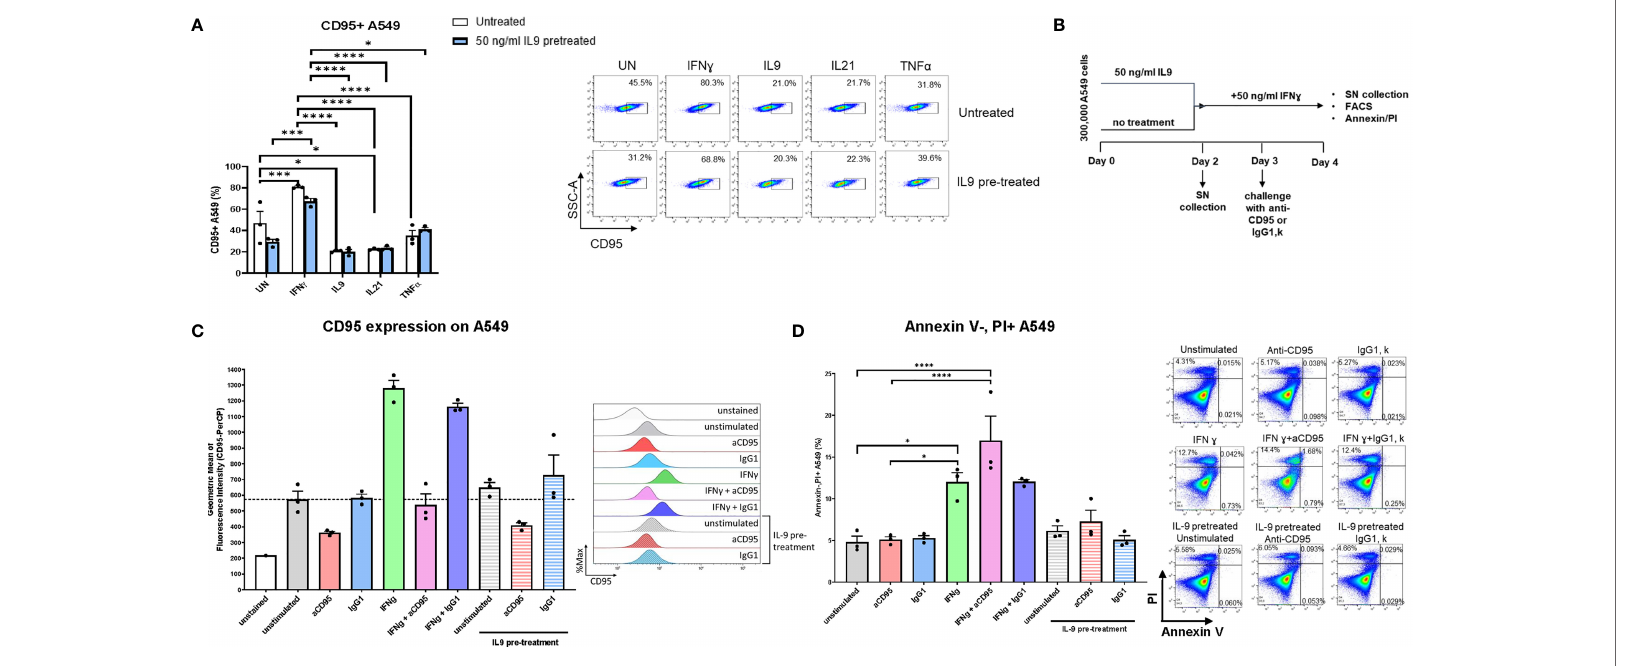
FIGURE 5 | Analysis of IL9 effects on tumor cell survival in vitro on A549 cell line. (A) Flow cytometry analysis of the percentage of CD95 (Fas) expressing A549 cells unstimulated or stimulated with IFN ɣ , IL9, IL21 or TNF a , respectively. Both IL9 pretreated and untreated A549 cells were analyzed . (B) Experimental design of A549 cell line culture for 4 days. (C) Flow cytometry analysis of the geometric mean of CD95 (Fas) expressing A549 cells unstimulated or stimulated with aCD95, IgG1, IFN g and a combination of aCD95 or IgG1 with IFN g , respectively. Furthermore, aCD95 and IgG1 stimulated cells were analyzed after IL-9 pre- treatment. (D) Flow cytometry analysis of the percentage of A549 necrotic cells (Annexin V-PI+ cells) in unstimulated cell culture condition or in condition of aCD95, IgG1, IFN g and a combination of aCD95 or IgG1 with IFN g , respectively. Furthermore, aCD95 and IgG1 stimulated cells were analyzed after IL-9 pre-treatment. A representative histogram (c) or dot plot (d) is shown for each group. The data were statistically analyzed with two-way ANOVA, and showed with mean ± SEM. n=3 per group. *P < 0.05; **P < 0.01; ***P < 0.001; ****P <